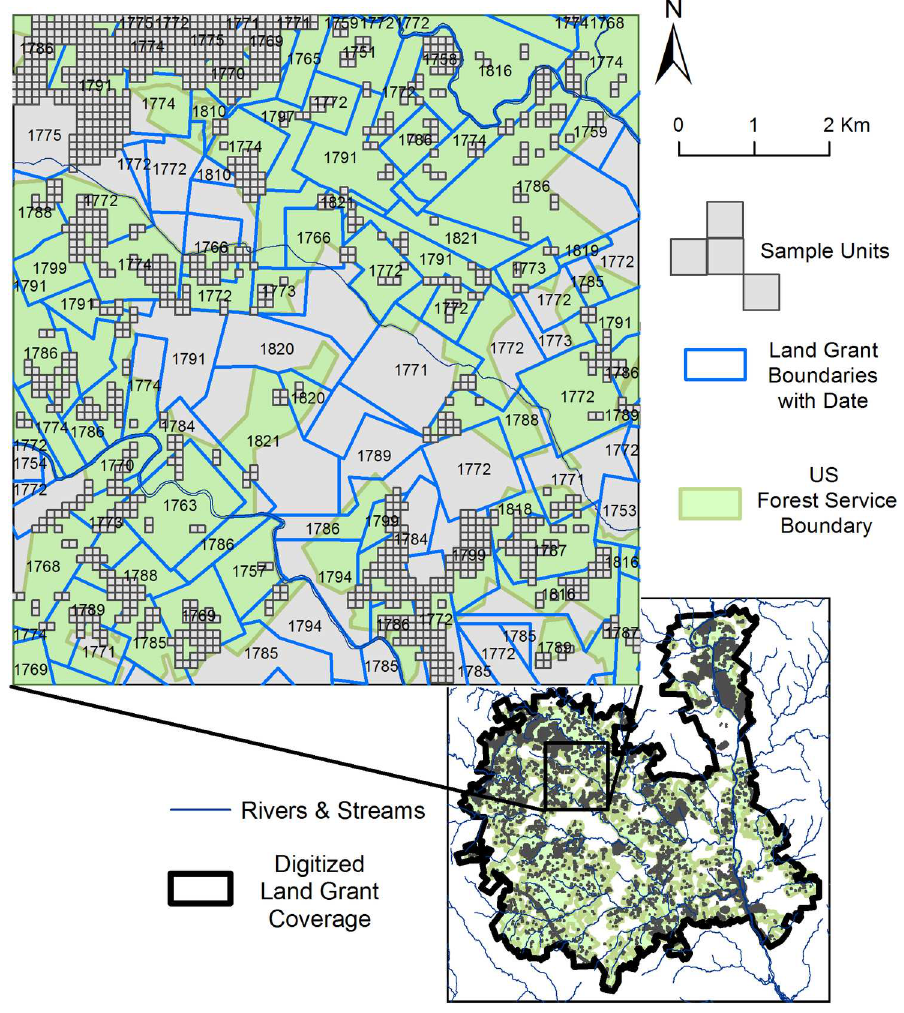
Fig 6. Sample strategy. 100 m 2 sample units with land grant boundaries and modern US Forest Service boundary.